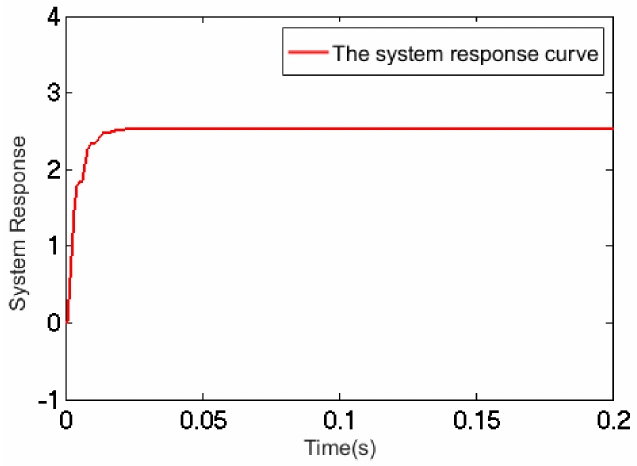
Figure 8. The system response